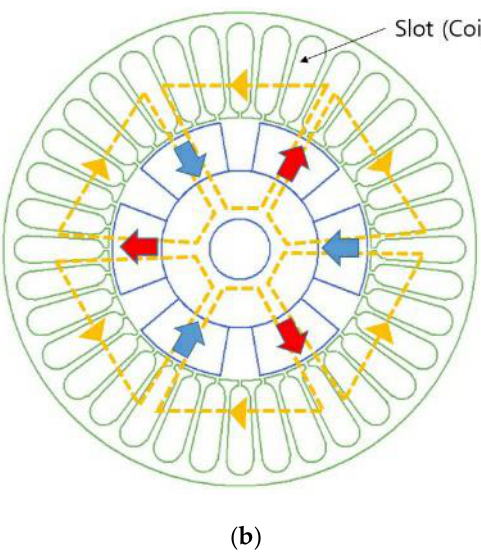
Figure 3. Structure explanation: ( a ) electromagnetic suspension structure; ( b ) A–A section view.